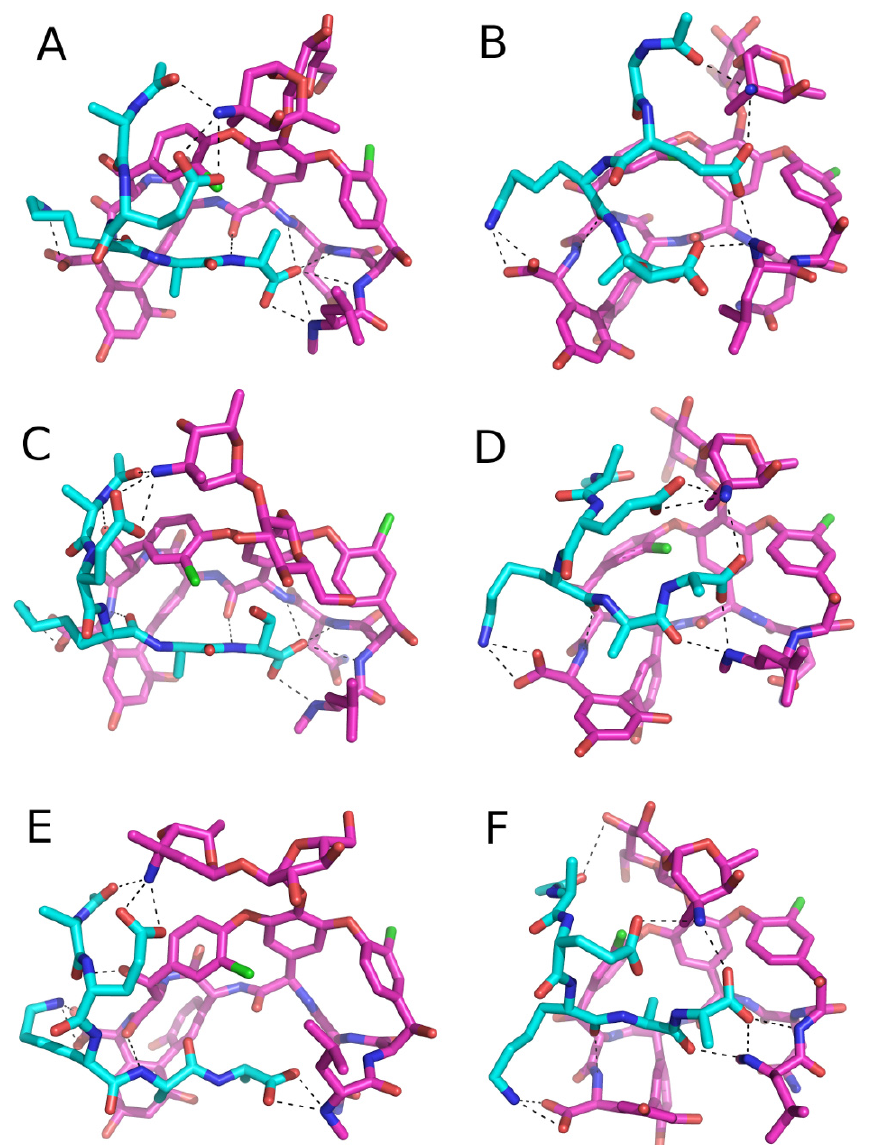
Figure 8. The polar interactions (including hydrogen bonds) identified in particular (natural and mutated) peptidoglycan fragments of peptidoglycan and vancomycin. Vancomycin – magenta; peptidoglycan – cyan; the polar interactions have been marked with dashed lines. Panel A – DA-DA; Panel B – DA-DLac; Panel C - DA-DSer; Panel D - DA-LA; Panel E - LA-DA; Panel F -